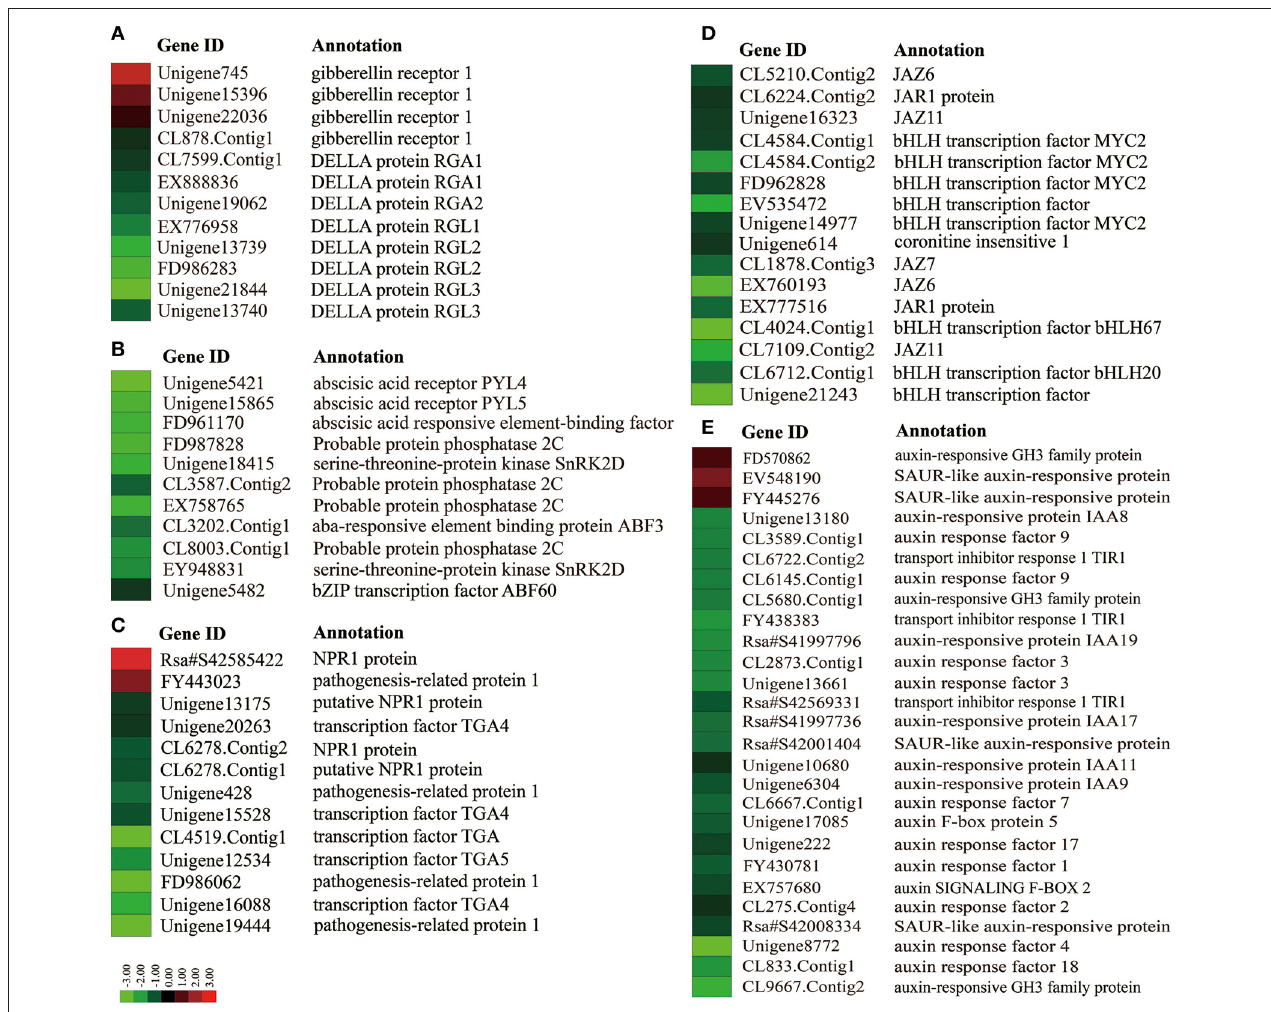
FIGURE 3 | Heat map diagram of expression patterns for DEGs involved in some phytohormone signaling pathways, including GA (A), ABA (B), SA (C), JA (D), and auxin (E). Red and green colors indicate up- and down-regulated genes in NAU-RS library as compared with NAU-VS library,